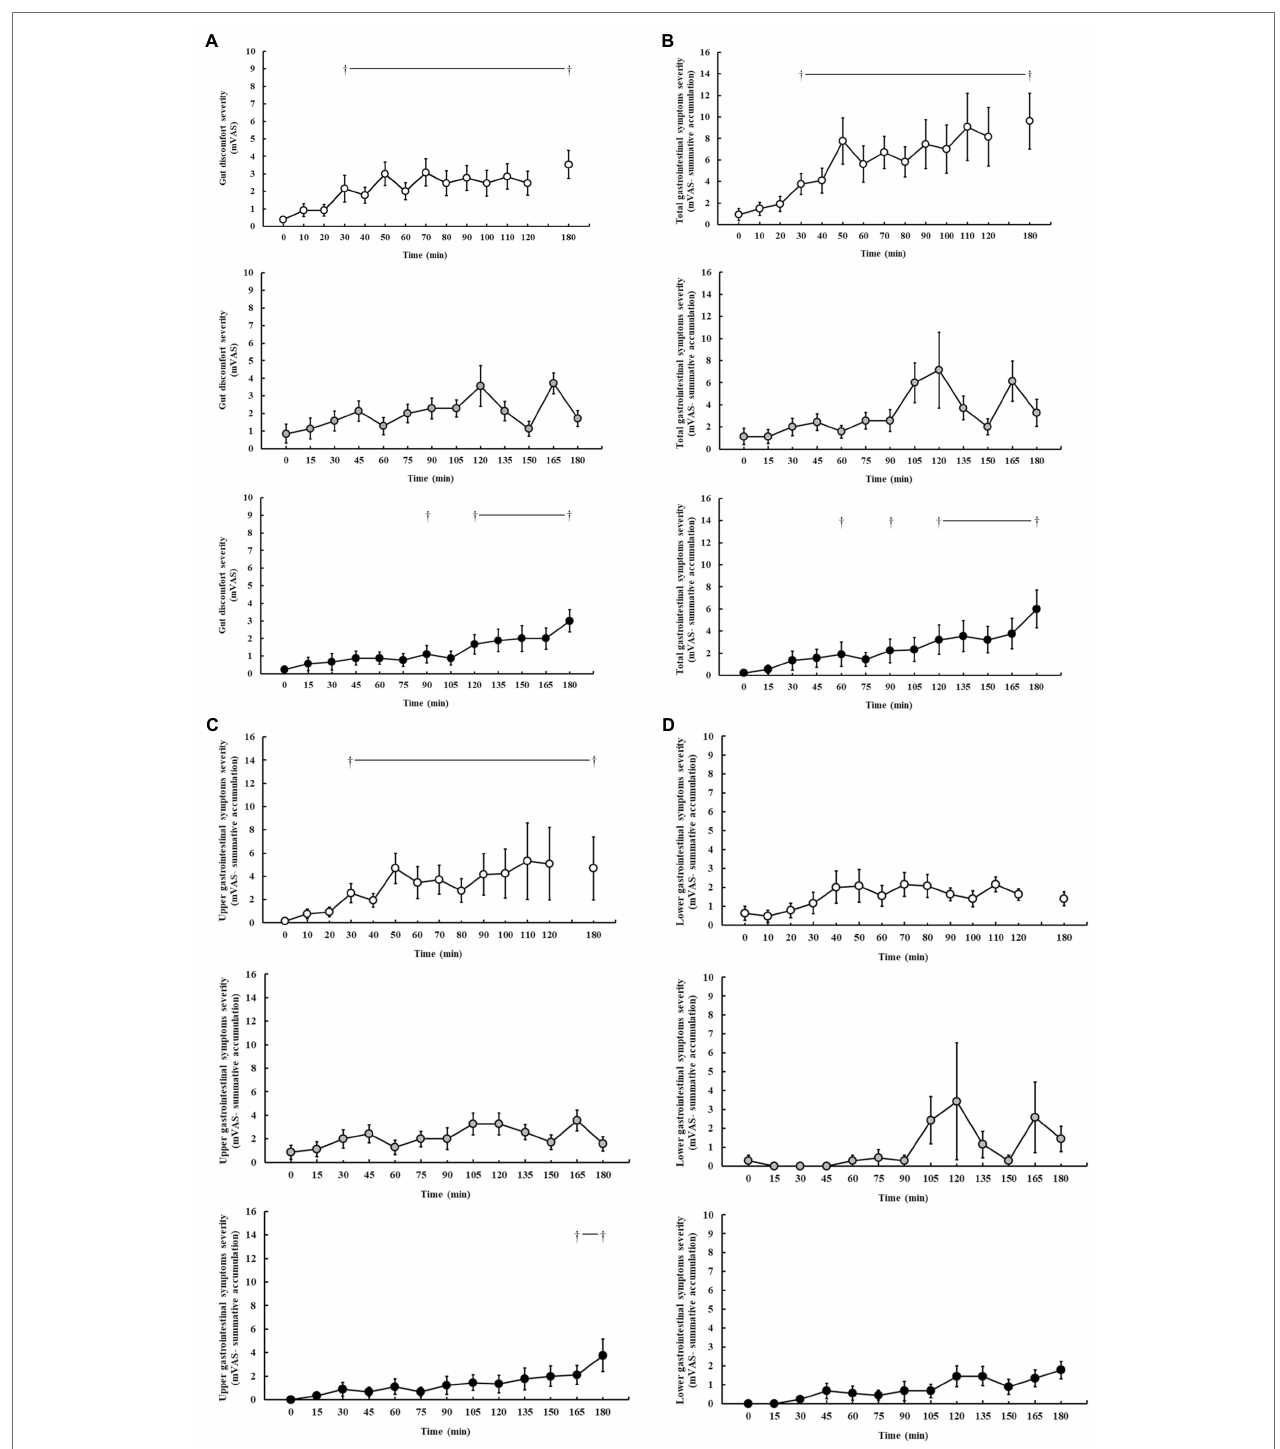
FIGURE 3 | Gut discomfort (A) , total (B) , upper (C) , and lower (D) gastrointestinal symptom severity rated on a exercise specific mVAS for gastrointestinal symptoms (Gaskell et al., 2019), during steady-state running with CHO provision on P1 ( ○ ), P2 ( ● ), and P3 ( ● ). Mean ± SEM ( n = 28): † p < 0.05 vs. pre-exercise (0 min) resting GIS. P1: formulated gel-disc containing 30 g CHO with 300 ml water (10% w/v , 90 g/h, 2:1 glucose–fructose, 316 mOsmol/kg), at 0 min and every 20 min thereafter for 120 min; followed by water provisions ad libitum for the 3rd h (270 ± 215 ml). P2: CHO beverage containing 25 ± 3 g CHO (10% w/v , 76 ± 8 g/h, 509 mOsmol/kg; equivalent to 1.0 g/ kgBM/h) at 0 min and every 20 min thereafter for 120 min, then water provisions ad libitum for the 3rd h (170 ± 122 ml). P3: CHO beverage containing 45 g CHO (16% w/v , 90 g/h, 2:1 glucose–fructose, 460 mOsmol/kg), at 0 min and every 30 min thereafter for 180 min. Water provisioned ad libitum, but not consumed by participants (0 ± 0